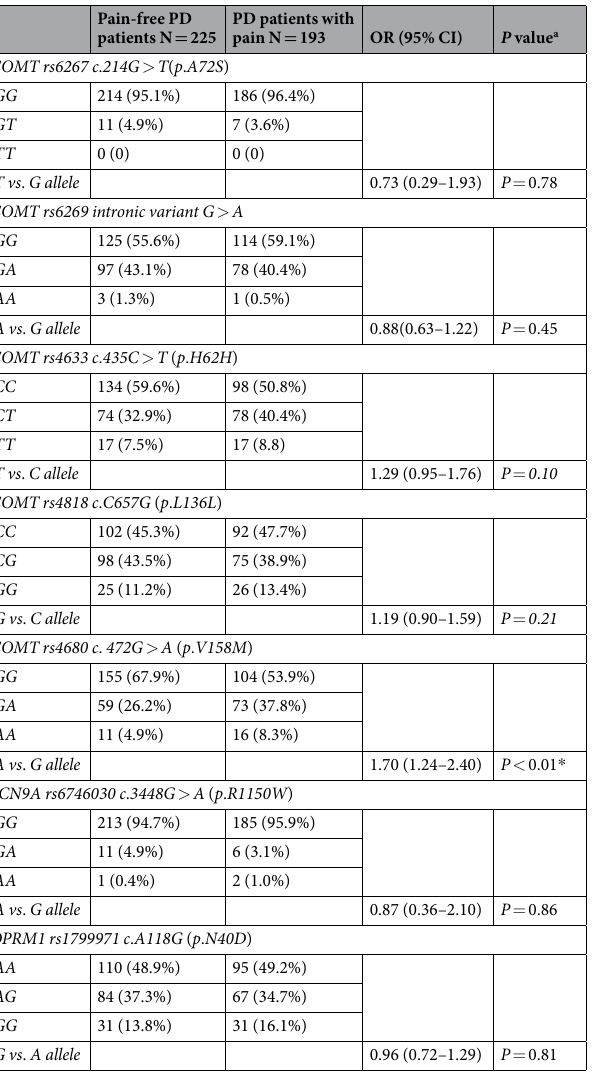
Table 1. Distribution of genotypes and estimated OR of nonsynonymous variants in relation to risk of pain in patients with PD. PD, Parkinson disease; OR, odds ratio; CI, confidence interval. a Chi-Square test or Fisher exact test (when frequency < 5) were applied. * P value remained significant after Bonferroni correction with conservative P = 0.05/4 =